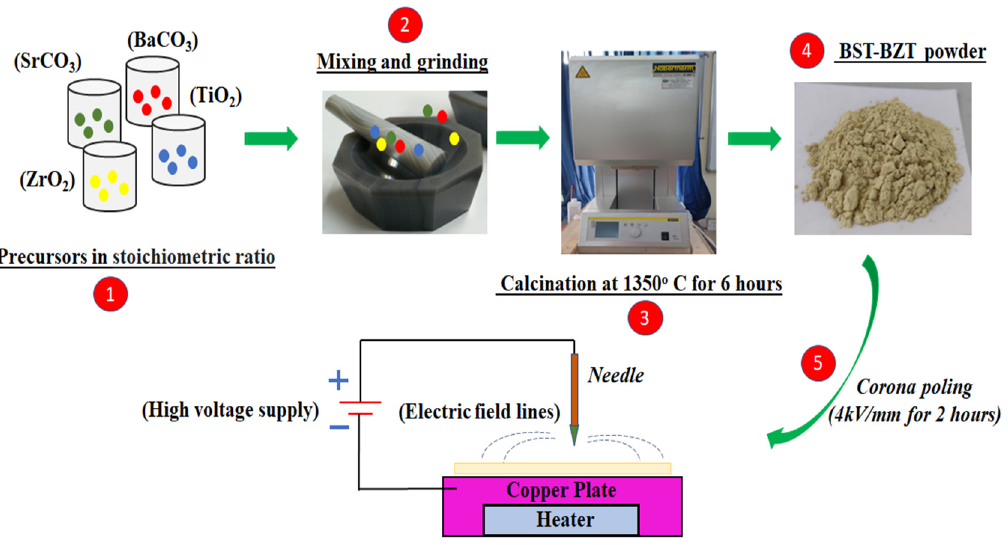
Figure 1. Schematic representation of BST ‒ BZT composition preparation and Corona poling.